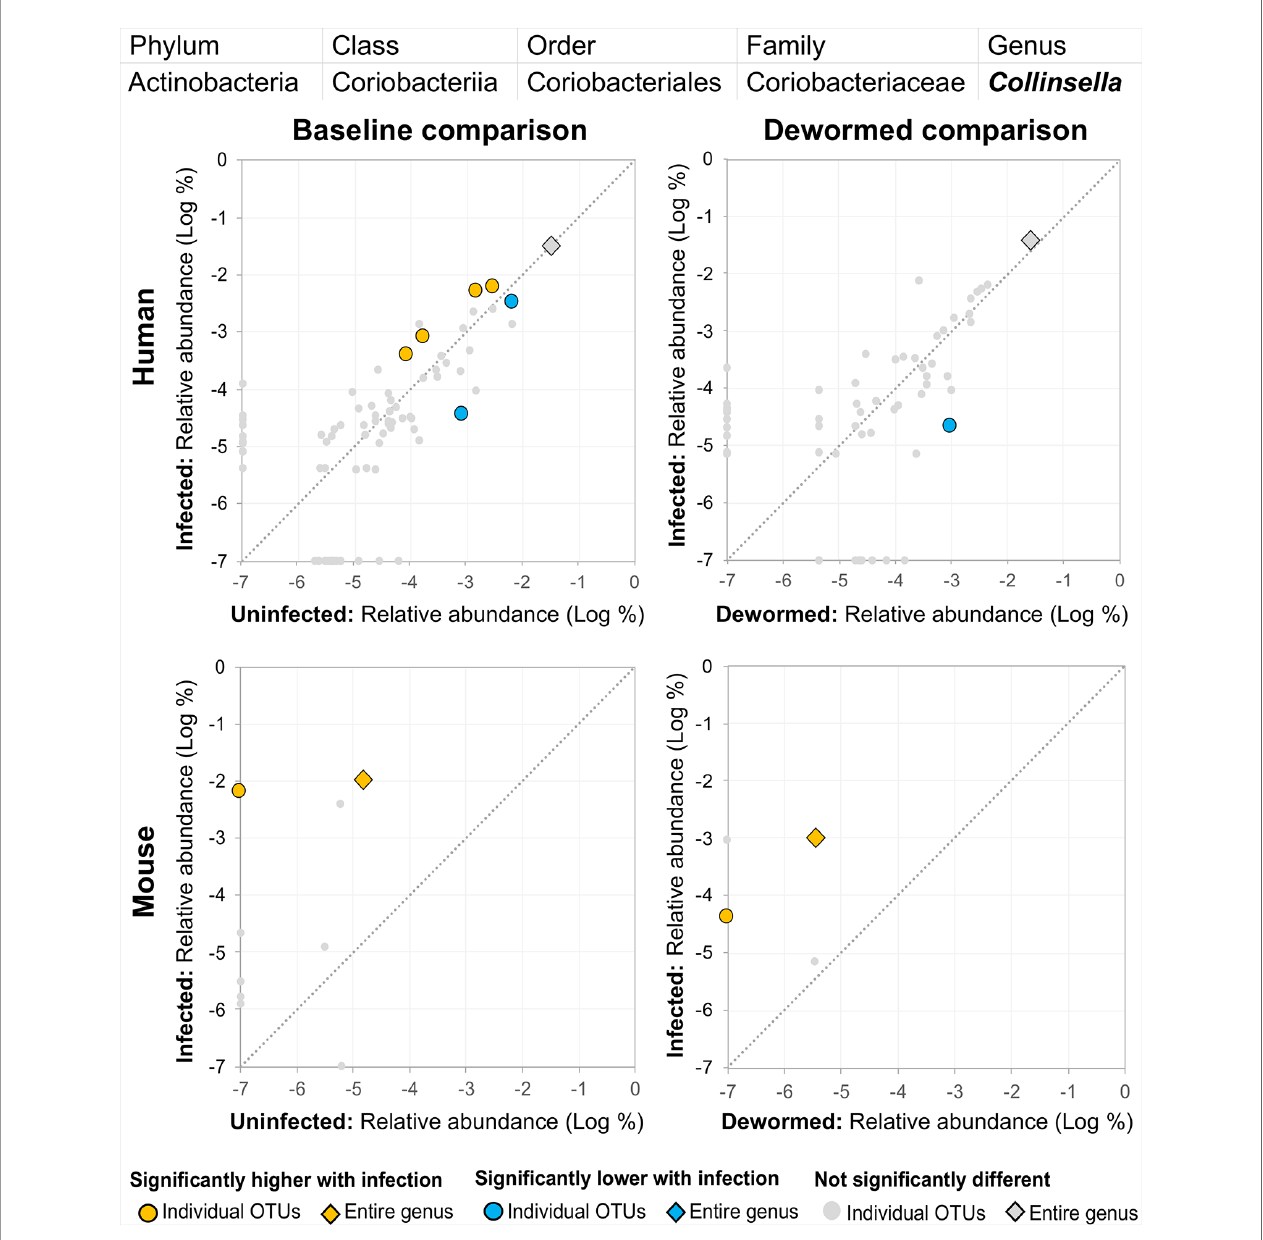
FIGURE 10 | The relative abundance (%) of all Collinsella (genus) OTUs in each differential comparison among samples from whipworm-infected and uninfected humans and mice. Signi fi cant differentially abundant OTUs in each comparison (as identi fi ed by LEfSe) are colored in orange (higher with infection) and blue (lower with infection). The sum of all OTUs in the genus is represented with a diamond symbol. This is one of three genera with at least one OTU signi fi cantly higher in infection in three of four